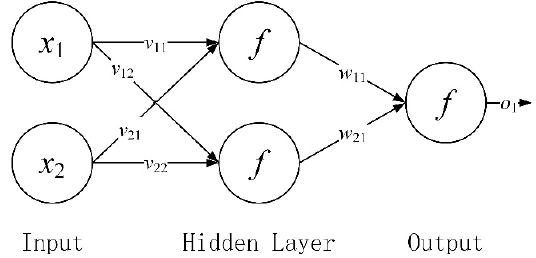
Figure 1. Sketch map of the BP neural